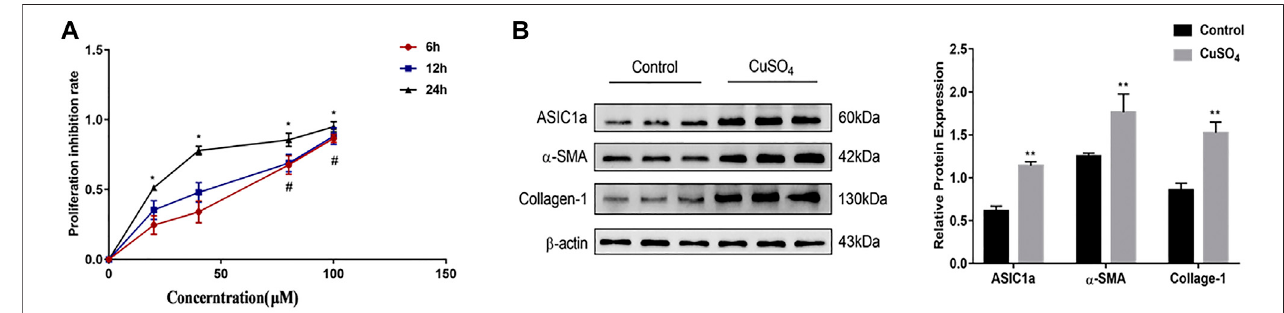
FIGURE1|(A) RatesofHSC-T6cellgrowthinhibitionaftertreatmentwithdifferentconcentrationsofcoppersulfatefordifferenttimes.Theconcentrationofcopper sulfate was set to 0, 20, 40, 80, and 100 µM. The data are shown as representative mitochondrial dehydrogenase activity as measured by CCK-8 assay. Data are expressed asthemean ± SEM( n (cid:2) 3). * p < 0.05vs.Controlgroup(24 h); # p < 0.05vs. Controlgroup (6&12 h) (B) Activation ofHSC-T6cellsand expression ofASIC1a in copper-treated cell models. The experimental group was repeated three times, and Western blotting analysis and densitometric quanti fi cation of ASIC1a, α -SMA,andCollagen-IproteinlevelsinHSCswereperformed.Statisticalanalyseswereperformedusingt-test.Dataareexpressedasthemean ± SEM( n (cid:2) 6).* p < 0.05, ** p < 0.01 vs. Control